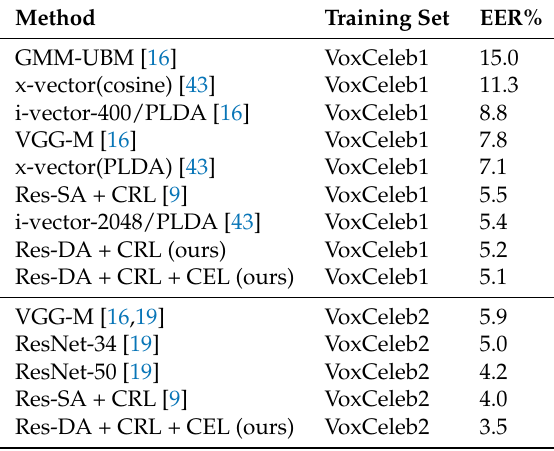
Table 11. Speaker verification results on the Voxceleb1 dataset (lower is